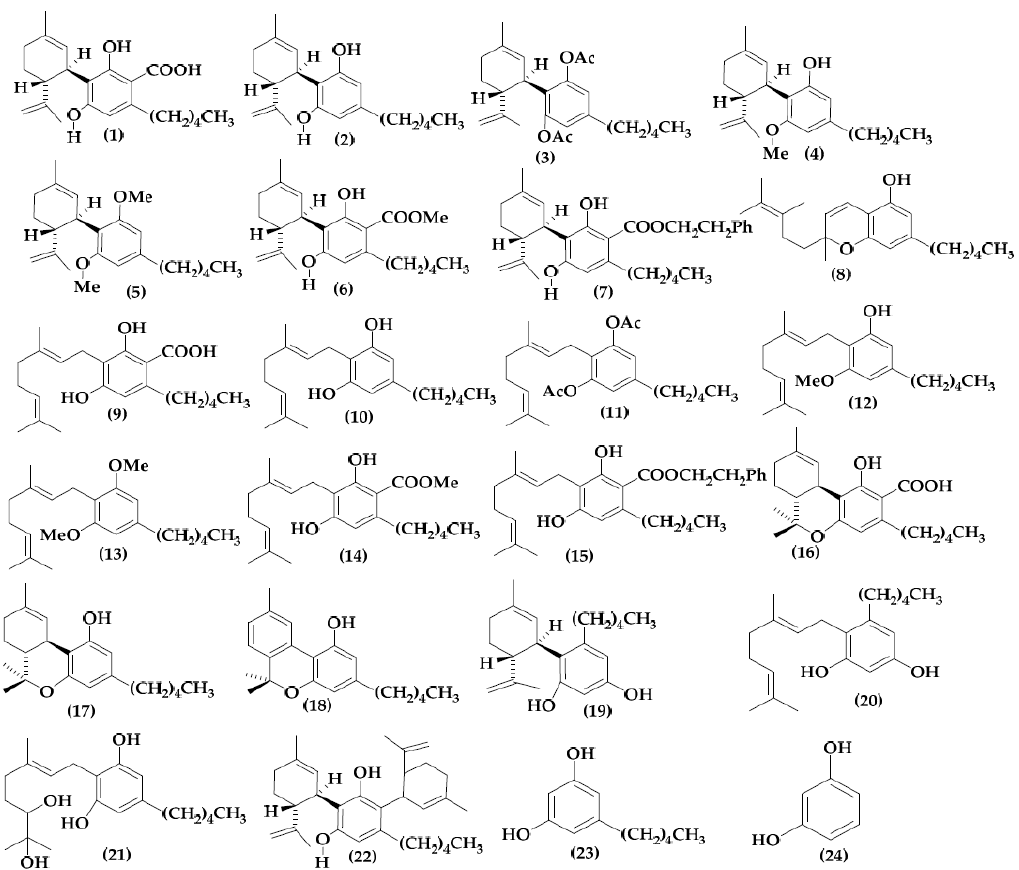
Figure 1. 2D structures for 24 cannabinoids studied in this work. Table 1. MIC, minimum inhibitor concentration, values for the cannabinoids in this study toward